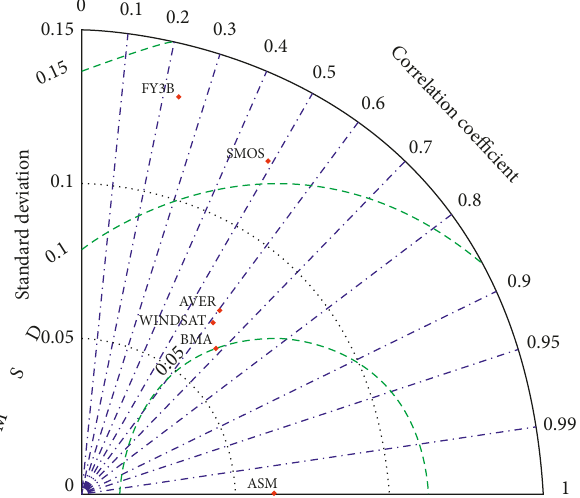
Figure 5: Taylor diagram for the region of the middle and lower reaches of the Yangtze River.